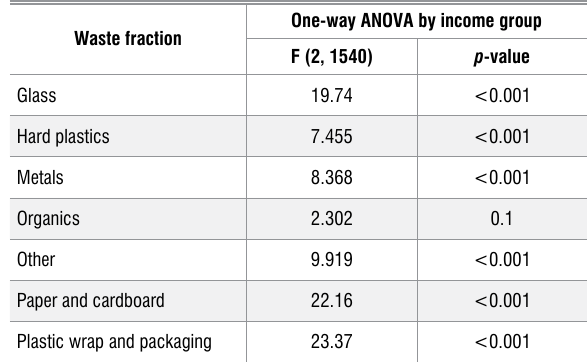
ANOVA comparing differences in means across income groups